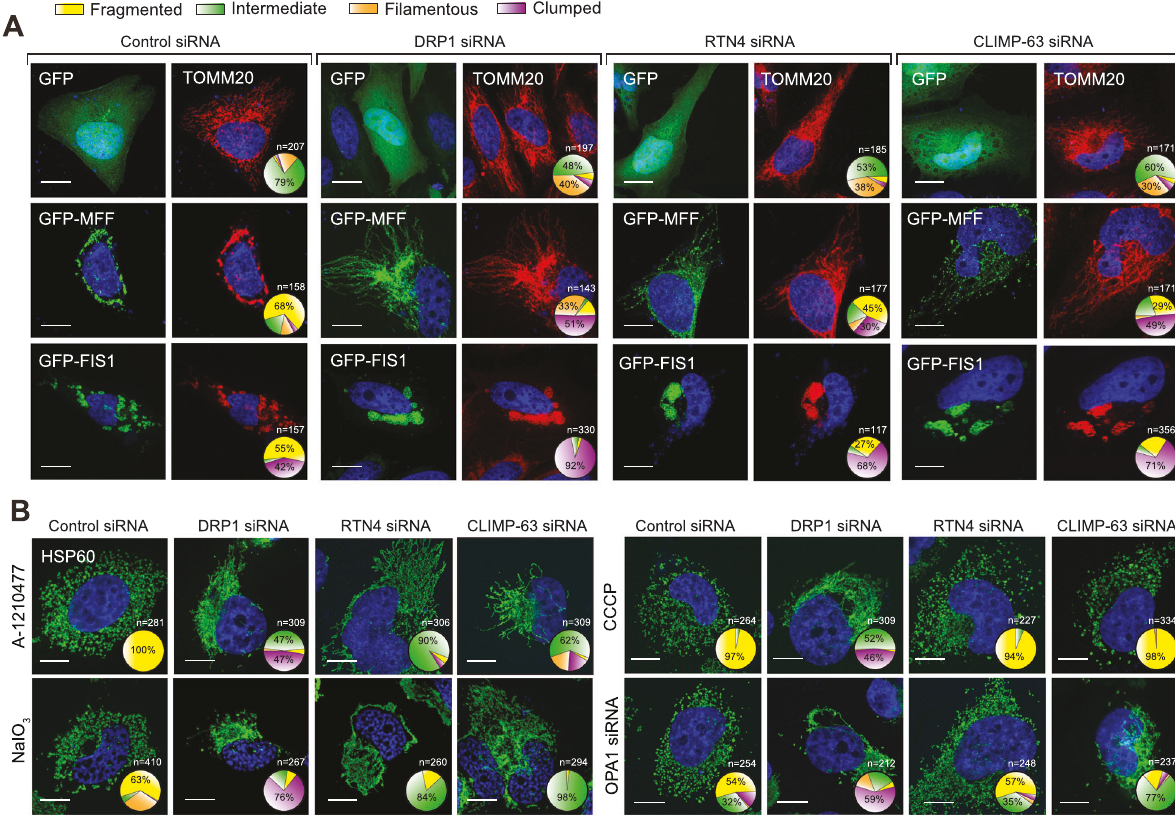
Fig. 3 Downregulation of the ER shaping proteins, RTN4 and CLIMP-63 antagonises the effects of several mitochondrial fragmentation inducers. A HeLa cells, transfected with a non-targeting control, DRP1, RTN4 or CLIMP-63 siRNA for 72 h, were also transfected with either a GFP, GFP-MFF or GFP-Fis1 plasmid for the fi nal 24 h, then immunostained using an antibody against TOMM20 (red). Mitochondrial morphologies were quanti fi ed in the indicated numbers of cells ( n ) per condition, across a minimum of 3 independent experiments, and the data plotted in pie charts here, and as bar graphs in Supplementary Fig. 13. B H1299 cells, transfected with a non-targeting control, DRP1, RTN4 or CLIMP-63 siRNA for 72 h, were exposed for 4 h to A-1210477 (10 μ M), NaIO 3 (100 μ M), CCCP (20 μ M) or co-transfected with OPA1 siRNA, immunostained using an antibody against HSP60 (green) and quanti fi ed as in A . Scale bars are 10 μ